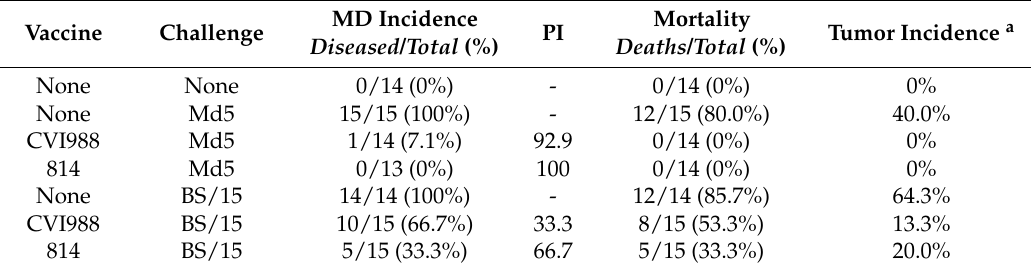
Table 2. Marek’s disease (MD) incidence, mortality, and tumor rates in each group at 90 dpc. Vaccine